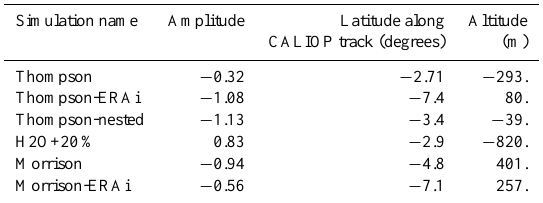
Table 4. Differences in amplitude and in vertical and horizon- tal centroid location between the simulated and observed ATB (a proxy for cloud position), along CALIOP track on 28 January 2009, 10:00